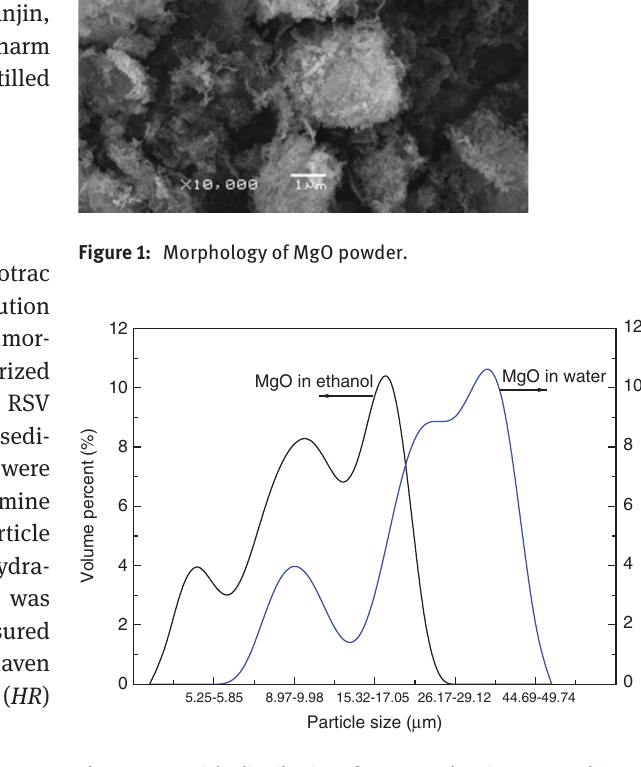
Figure 2: Particle distribution of MgO powders in water and in